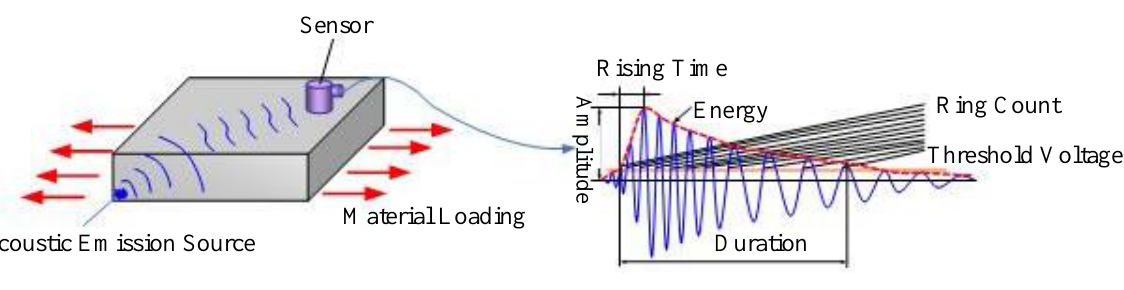
Figure 1. Principle of Acoustic Emission